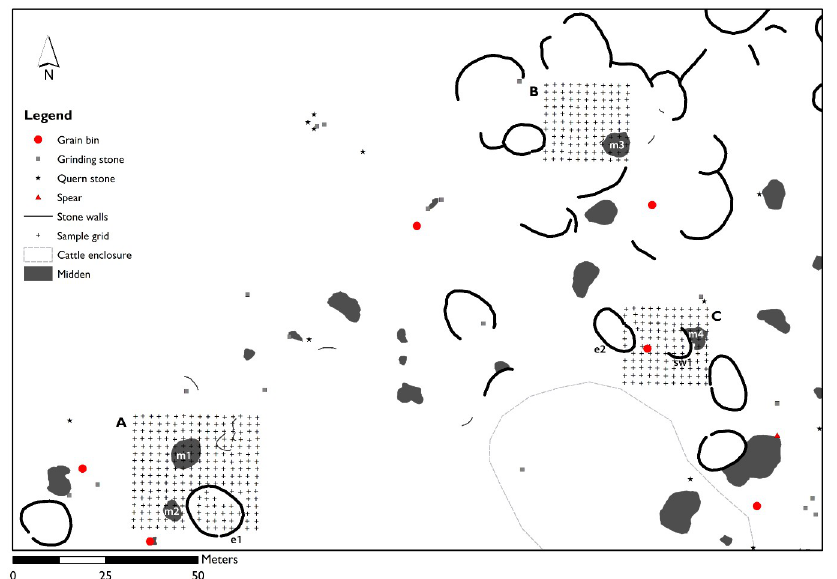
Fig 4. Map of the sampled areas at Seoke northernmost cluster showing detail of the features recognised during ground survey. The features discussed in the paper are numbered in a progressive way: enclosure 1 (e1), midden 1 (m1) and midden 2 (m2) in area A; midden 3 (m3) and enclosure 2 (e2) in area B; stone wall 1 (sw1) and midden 4 (m4) in area C.